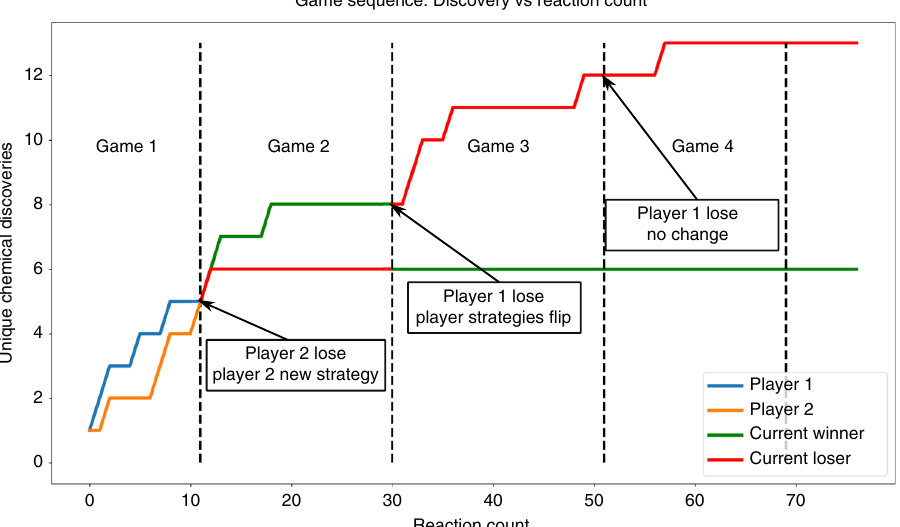
Fig. 8 Discoveries over time player 1 vs player 2. A four Hex game sequence between two automated platforms. Game 1: initial game to establish winner/ loser (same strategy), game 2: initial loser begins using expanded strategy and wins, no signi fi cant change in discoveries, games 3 and 4: players switch strategy for the fi nal time, loser continues to make signi fi cantly more discoveries until the series